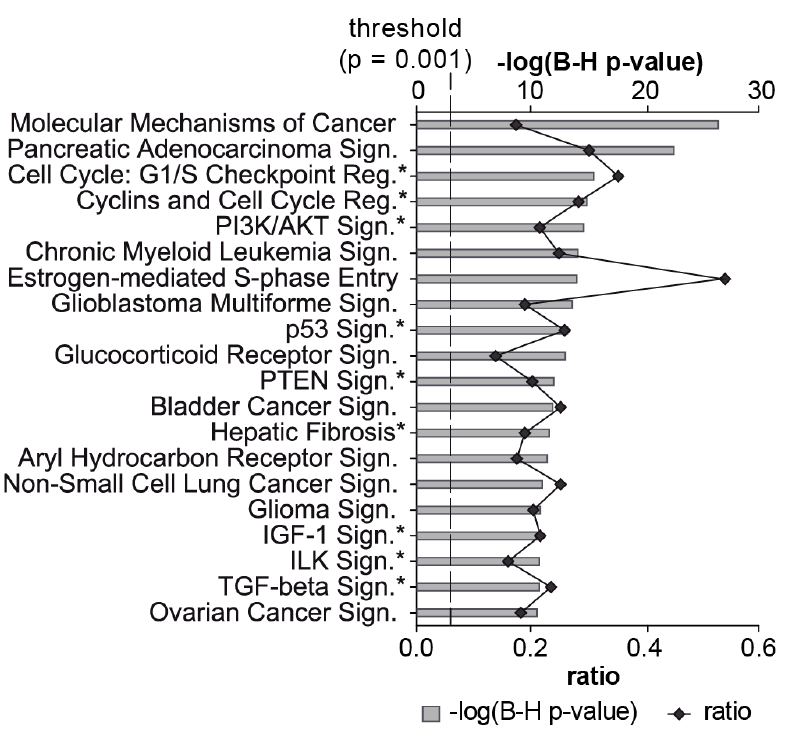
Figure 5. Top 20 enriched signaling pathways targeted by miRNAs expressed in ATII cells. The 111 miRNAs expressed at similar levels in pATII and sATII were used as inputs for the miRNA target filter module in Ingenuity ® . The top 20 signaling pathways associated with the dataset are shown. The significance of this association is expressed by the probability (grey bars) that the association between the targets and the pathway is not due to chance (BH-adjusted p -value, Fisher’s exact test). The degree of miRNA interaction within a certain pathway was calculated as the ratio of the number of targets that map to a given pathway to the total number of molecules within the pathway (black line). The dashed line indicates the significance threshold at p = 0.001. An asterisk highlights signaling pathways that have been associated previously with fibrosis and/or EMT. Table 3. Categories of pathways with significant ATII miR–target enrichment.